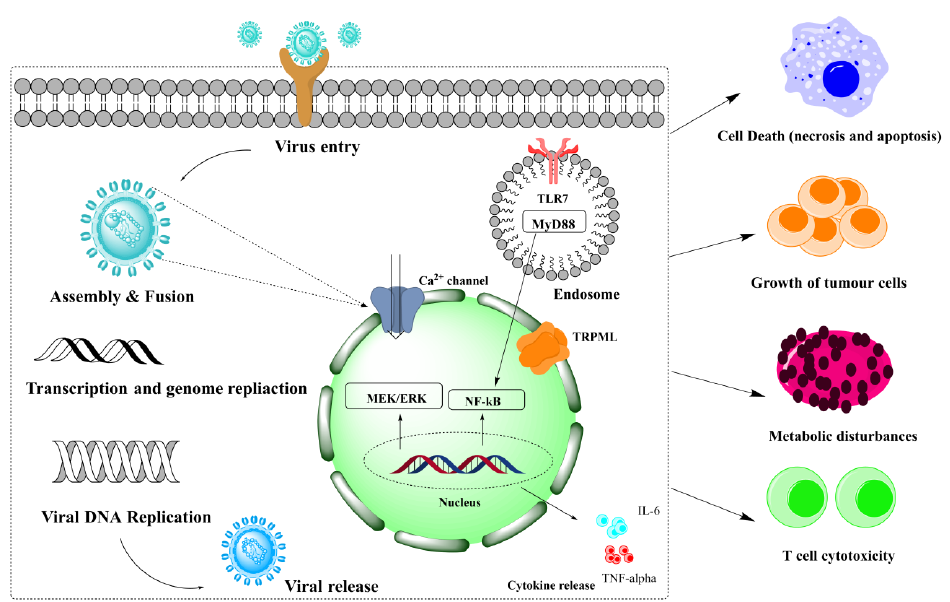
Figure 2. Various steps involved in the pathology of viral infections that might harm cells. MEK/ERK: Mitogen-activated protein kinase/extracellular-signal-regulated kinase, NF- κB: nuclear factor kappa B, TRPML: transient receptor potential, TLR7: Toll-like receptor (TLR)-7, MyD88: myeloid differentiation primary response protein, TNF- α: tumor necrosis factor alpha, IL-6: interleu- kin-6.